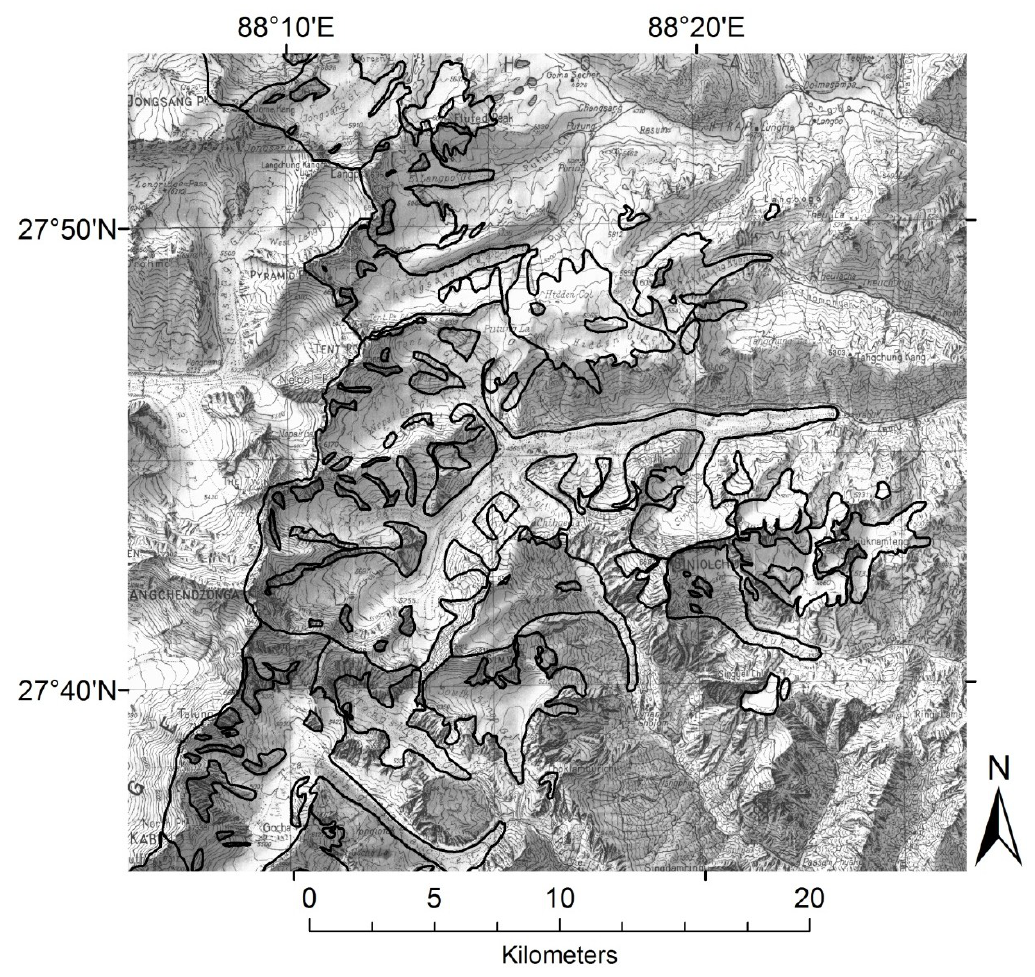
Figure 3. Sikkim section of the Swiss Foundation for Alpine Research topographic map at 1:150,000 used as baseline data in this study. Black solid lines represent glaciers digitized manually from the 1970s topographic